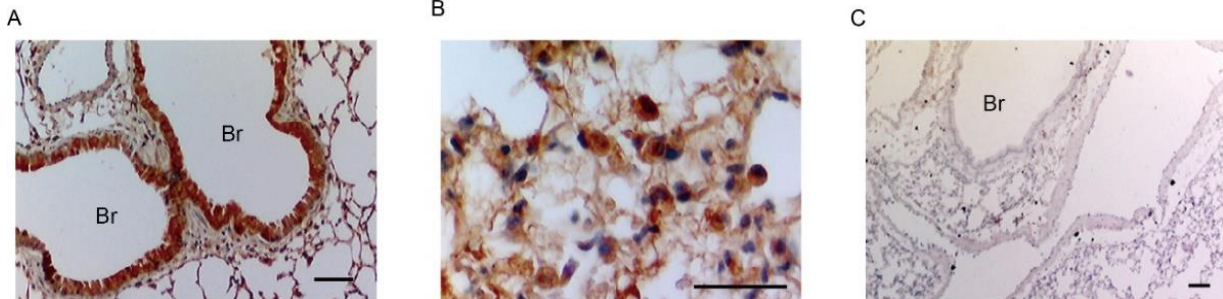
Figure 3. FP receptors were expressed on bronchial epithelium and in alveolar macrophage-like cells. The lung was extracted at 6 h after HCl administration. ( A , B ) Representative images of FP receptor-stained lung sections of HCl-treated mice (Br: bronchus, scale bar: 25 µm). ( C ) Representative stained image of the lung without the primary antibody ( n = 5).